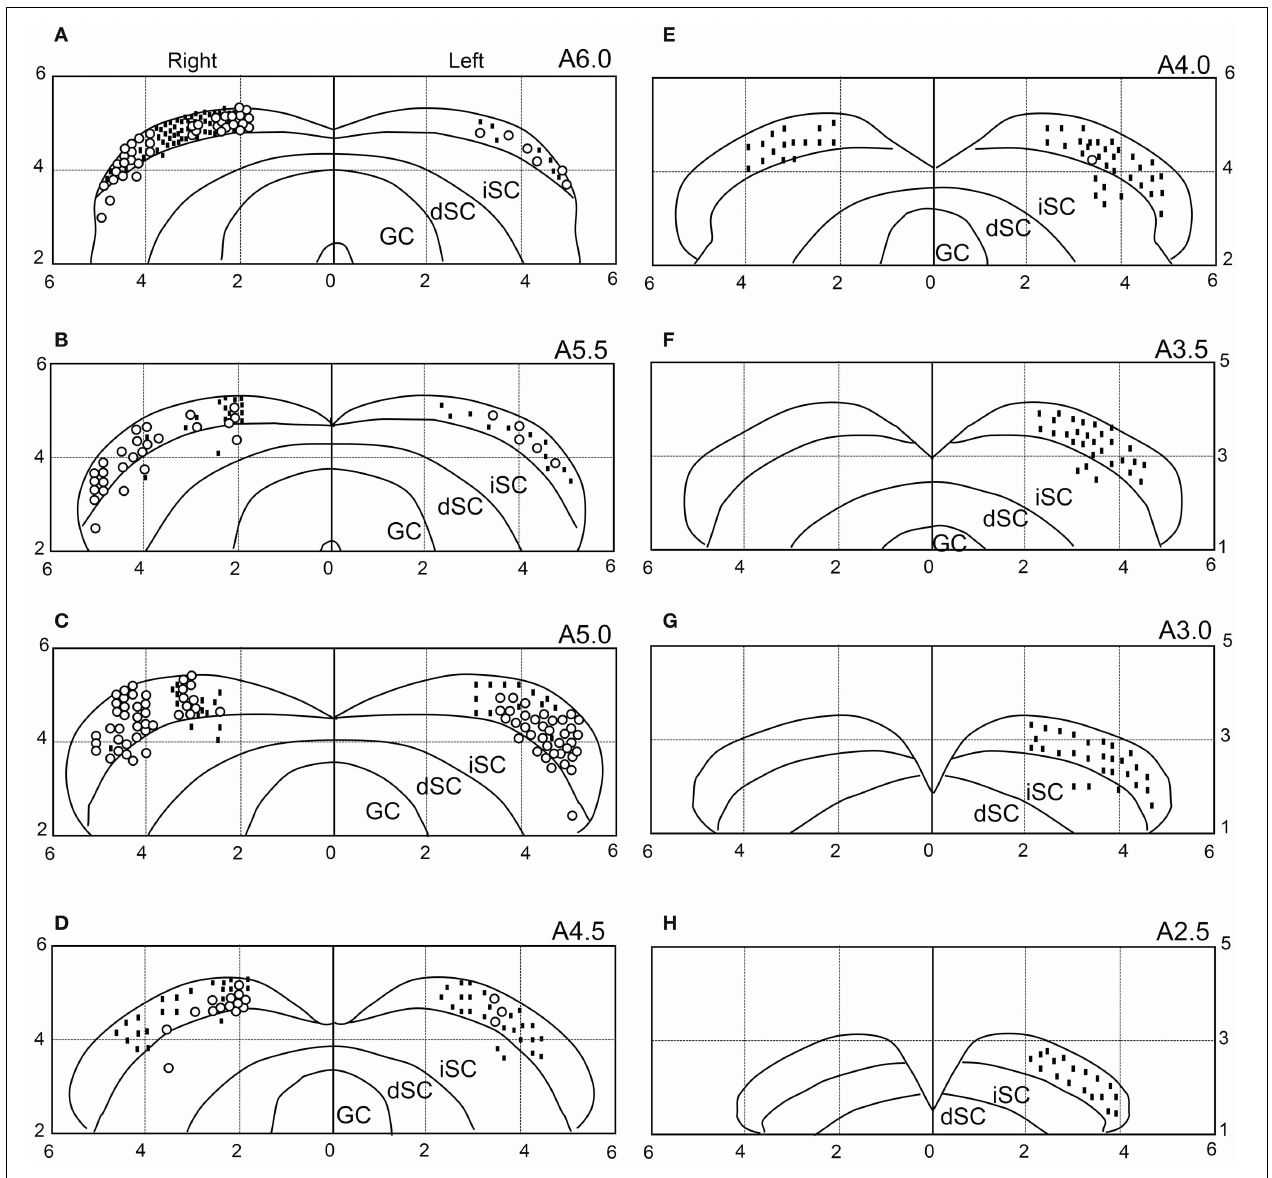
FIGURE 12 | Recording sites of the 646 SC neurons. The number in the upper right corner of each section indicates the distance (mm) from the interaural line (anterior posterior level). Horizontal and vertical axes indicate the distance (mm) from the midline and the interaural line, respectively. Open circles, visually responsive neurons; dots,